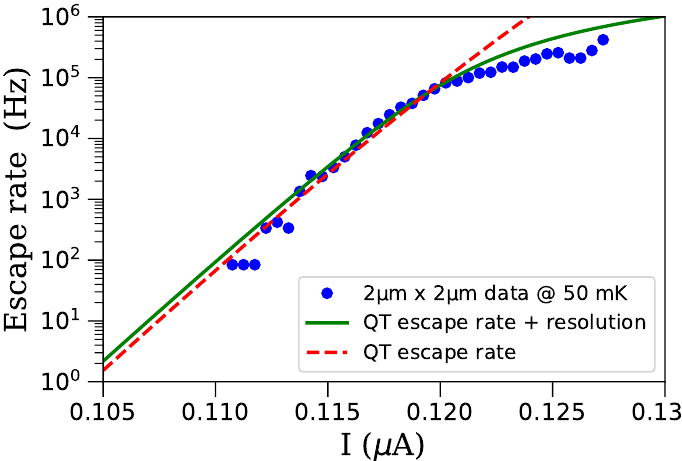
2 µ m junction at 50 mK, compared with ×